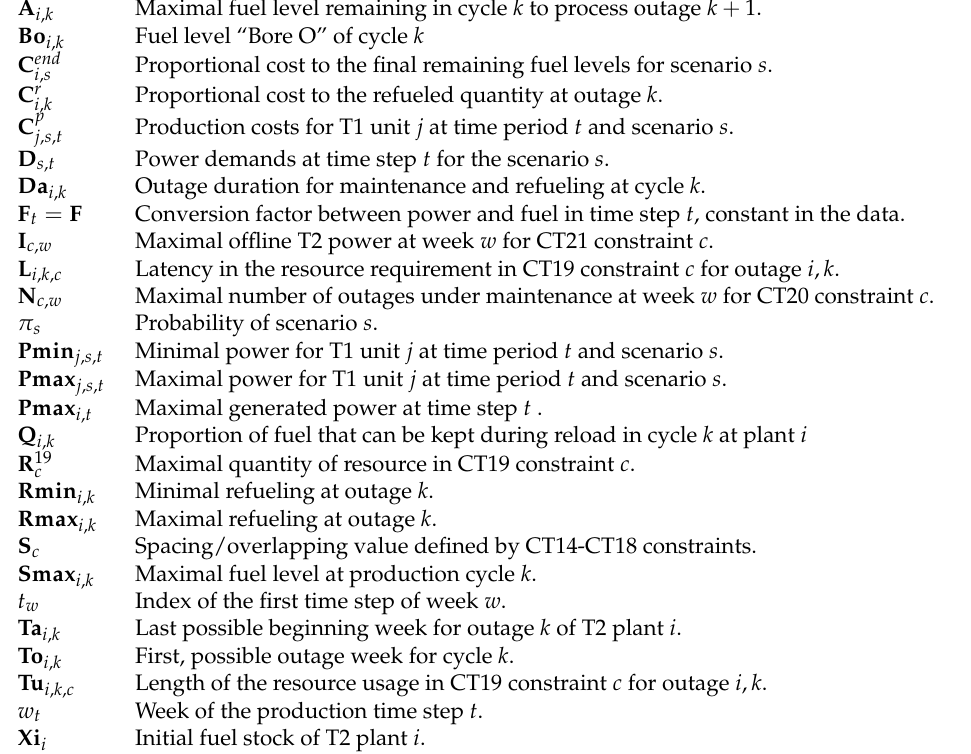
Table 2. Definitions and notations—the input